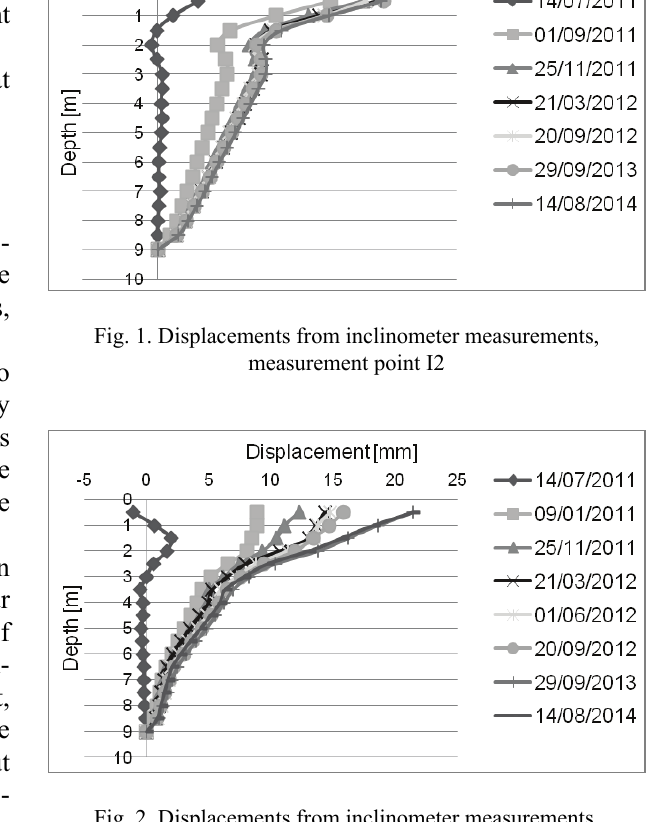
Fig. 2. Displacements from inclinometer measurements,